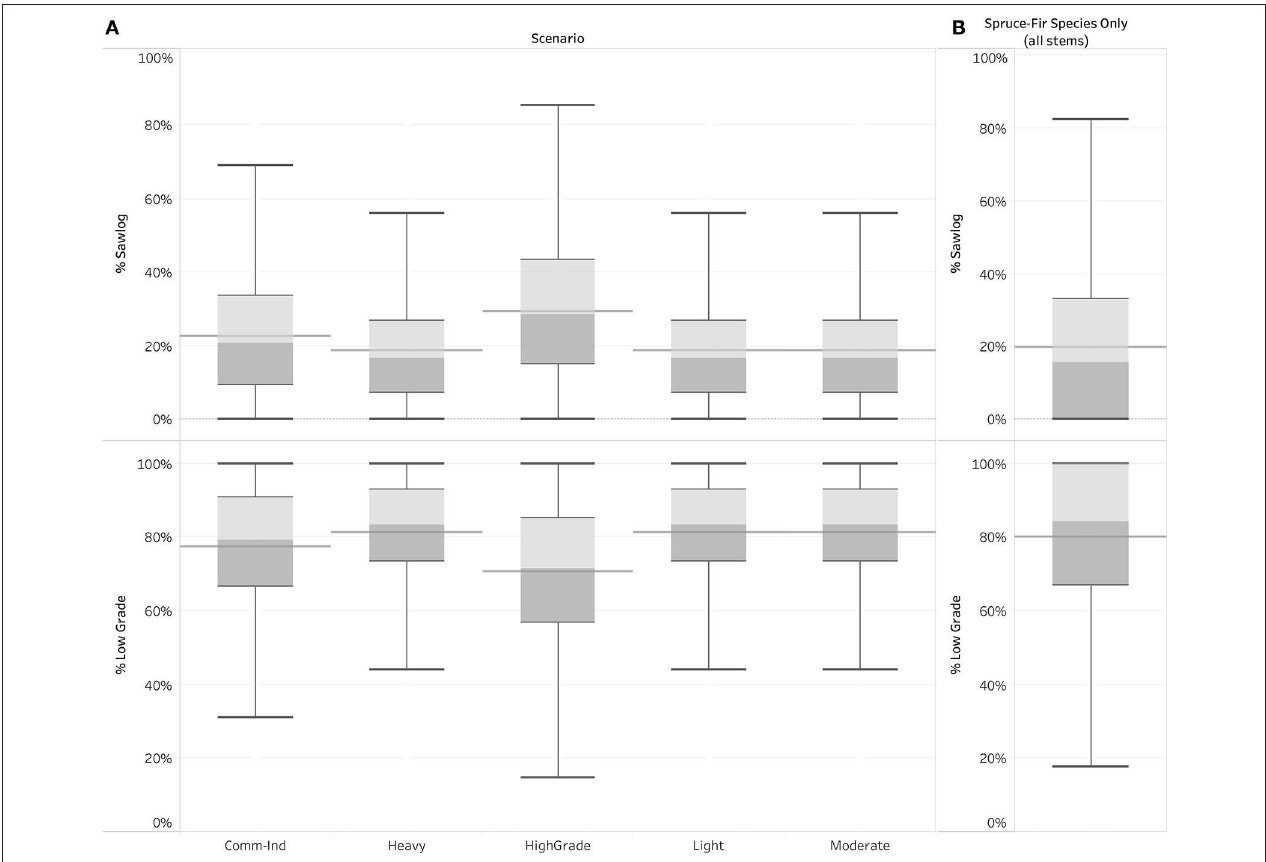
FIGURE 6 | (A) Ratio of sawlog to low-grade quality wood removed in each harvest scenario (all species). (B) Ratio of sawlog to low-grade quality wood for spruce-fir species (calculated from all the standing stems at year 0 prior to any